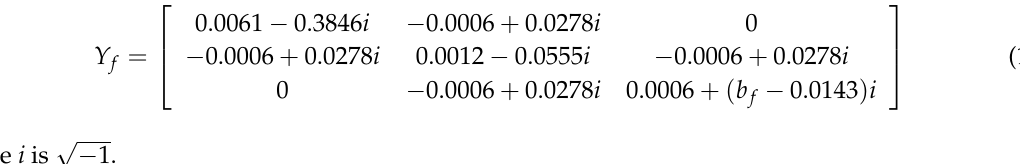
f b Figure 6. | λ | min with the change of b f From Figure 6, it can be seen that | λ | min is about between 0.02 and 0.05 for most regions of b f . And, when | λ | min is under 0.005, it is very close to zero, which indicates the occurrence of harmonic resonance. Therefore, for Equation (19), ε is set as 0.005, and the PFD can be obtained as b f  [−0.1, −0.0066]  [0.0060, 0.1], by the principle that | λ | min should be greater than ε (as the dotted line in Figure 6).